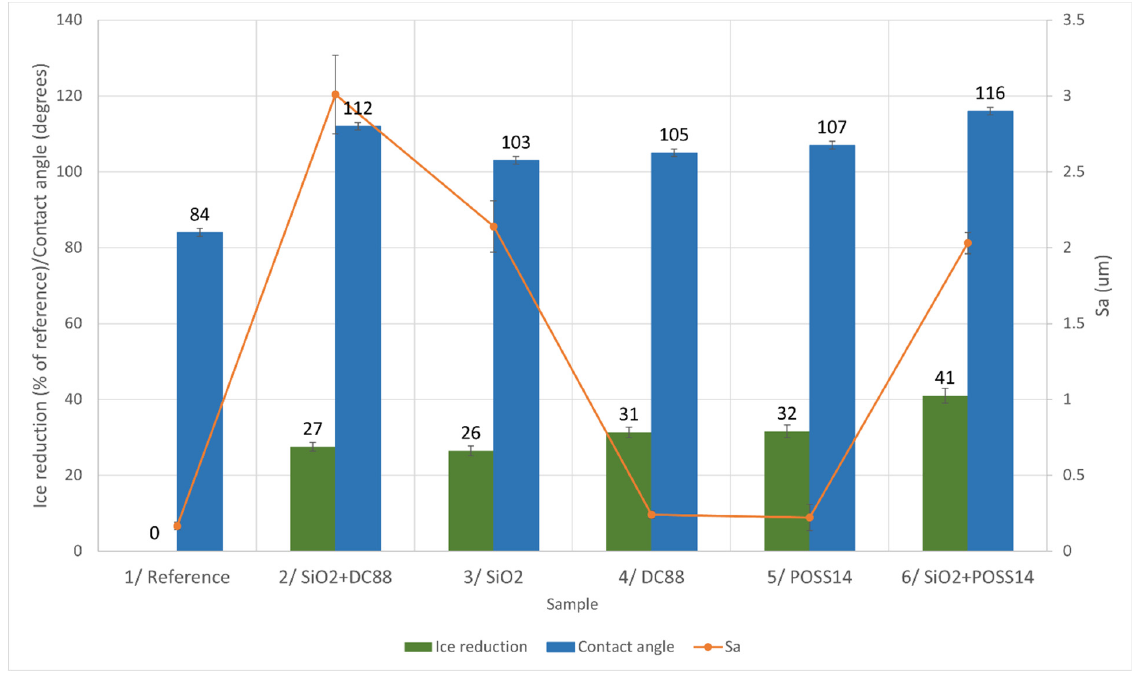
Figure 8. Comparison of different characteristics in aspect of rime ice reduction.